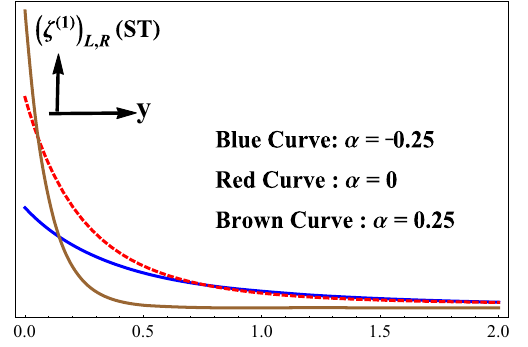
( = ζ ( 1 ) ( ST ) in the diagram) vs. y for M = 1, (cid:9) = − 1 Fig. 9 ˜ ζ ( 1 ) L , R L , R = 0 . and m 5 k